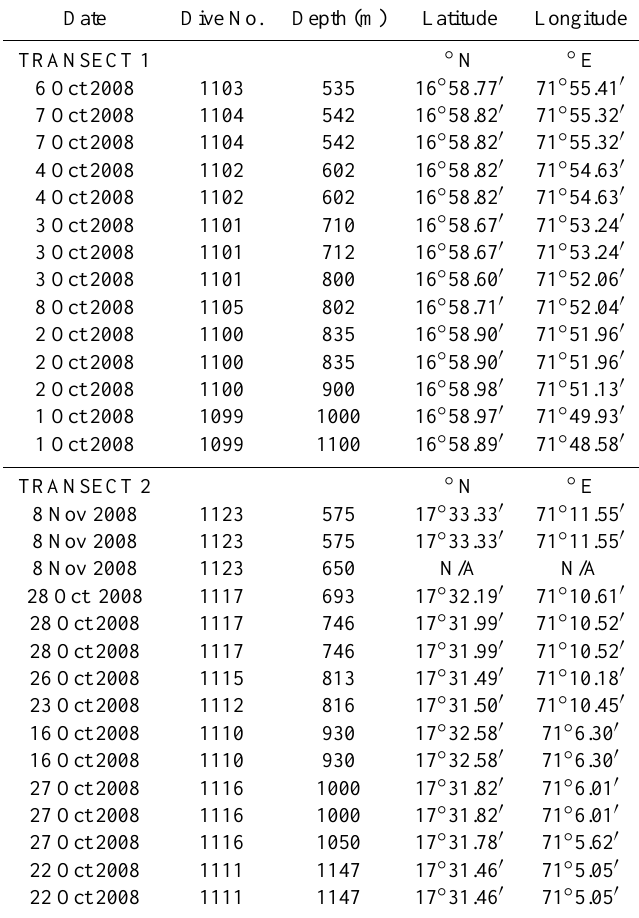
Table 2. Date, dive number, depth and location of background sediment cores collected for macrofaunal analysis. Each row reflects a single